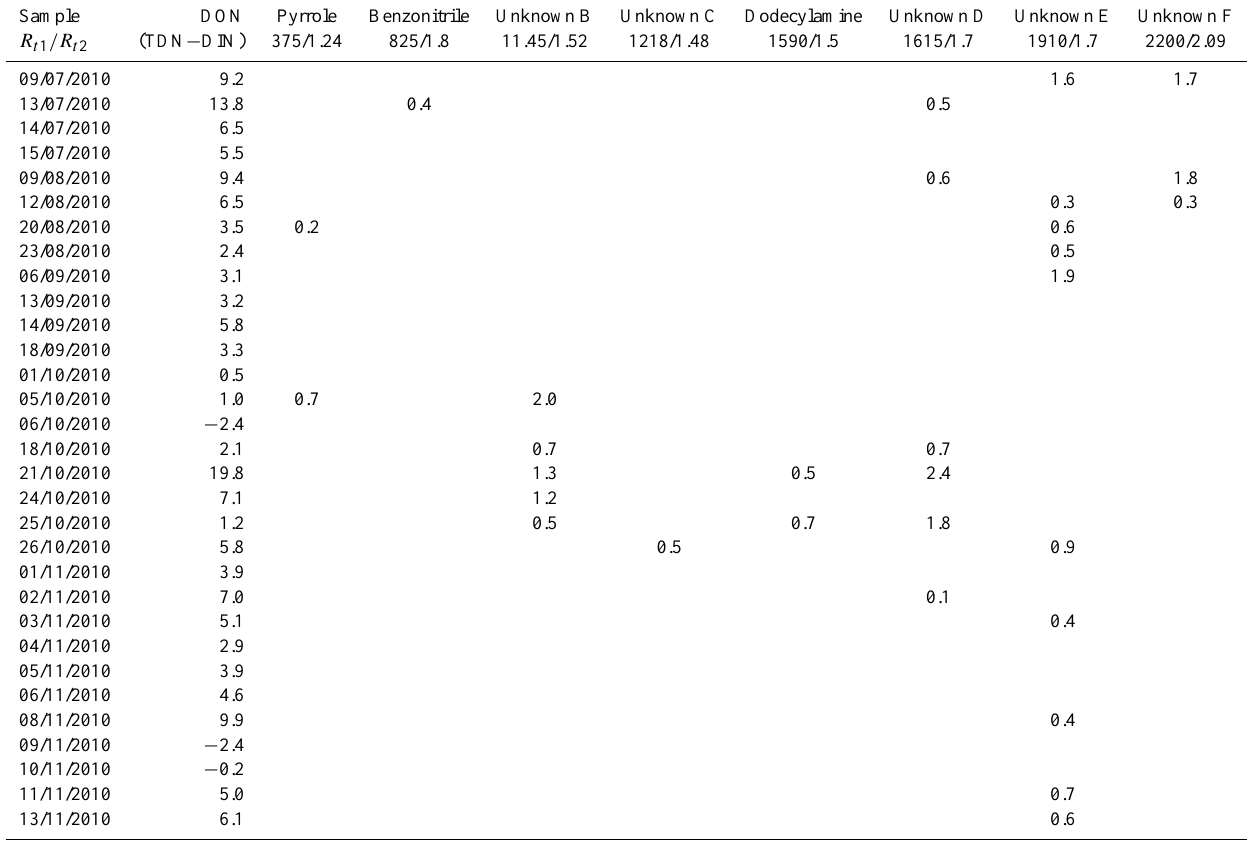
Table 4. Summary of compounds and their concentrations (µmolNL − 1 ) detected by the GC × GC-NCD, and overall DON concentrations (µmolNL − 1 ) derived from TDN − DIN in precipitation samples. Samples collected on dates shaded in grey did not contain compounds at measurable concentrations by the GC × GC-NCD. Blank spaces indicate a value below the detection limit. R t 1 and R t 2 are retention times in seconds for the first and second GC